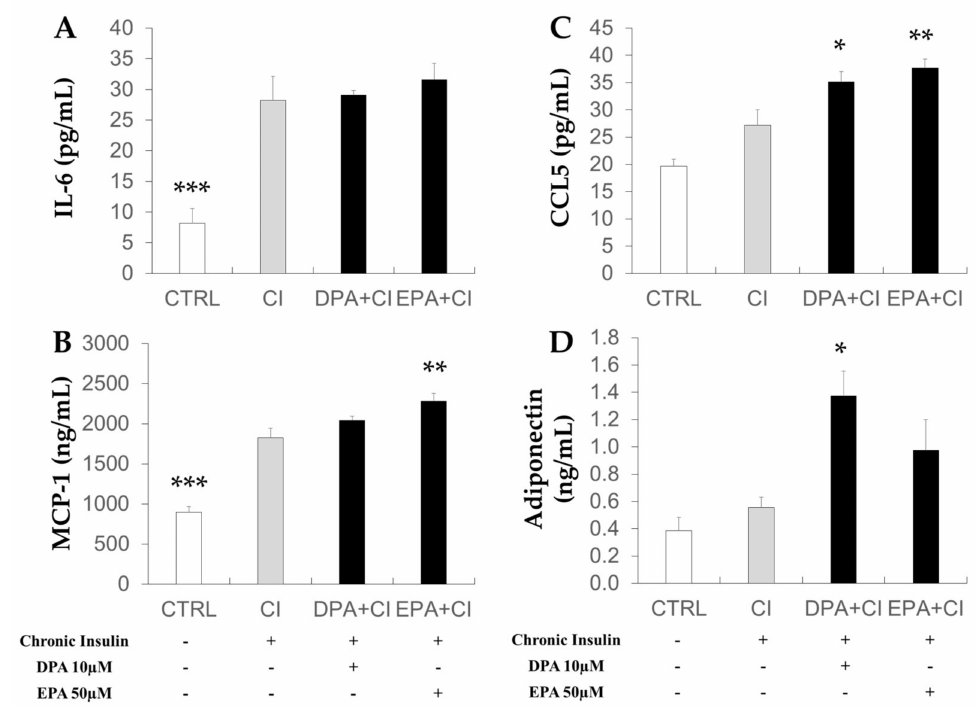
Figure 5. Effects of chronic insulin and LCn-3PUFA on adipokine secretion by mature adipocytes. 3T3-L1 preadipocytes were differentiated for eight days before a 48-hour treatment with 10 µ M docosapentaenoic acid (DPA) or 50 µ M eicosapentaenoic acid (EPA). Insulin resistance was induced by adding insulin (10 µ M) during the last 16 h of treatment (chronic insulin, CI). Cells were then